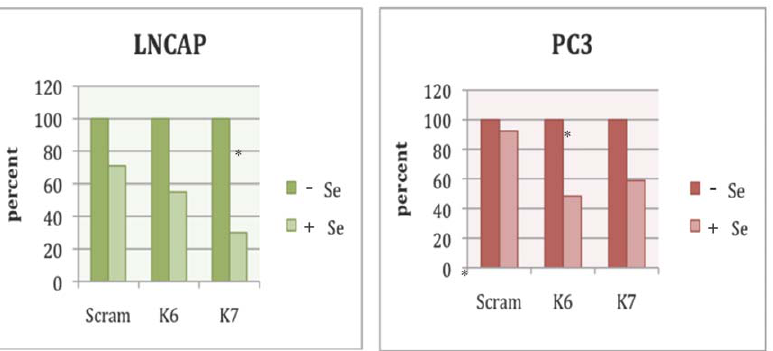
Figure 2. KCNMA1 knock down in LNCaP and PC3 cell lines using siRNA methodology. The percent reduction in response is plotted as a bar graft, the first bar in each set indicating the absence and the second bar representing the presence of selenium treatment of both cell lines. The siRNA experiments are done in triplicates and the average is taken. The (*) indicates the statistically significant (p , 0.05) differences in response to selenium treatment.